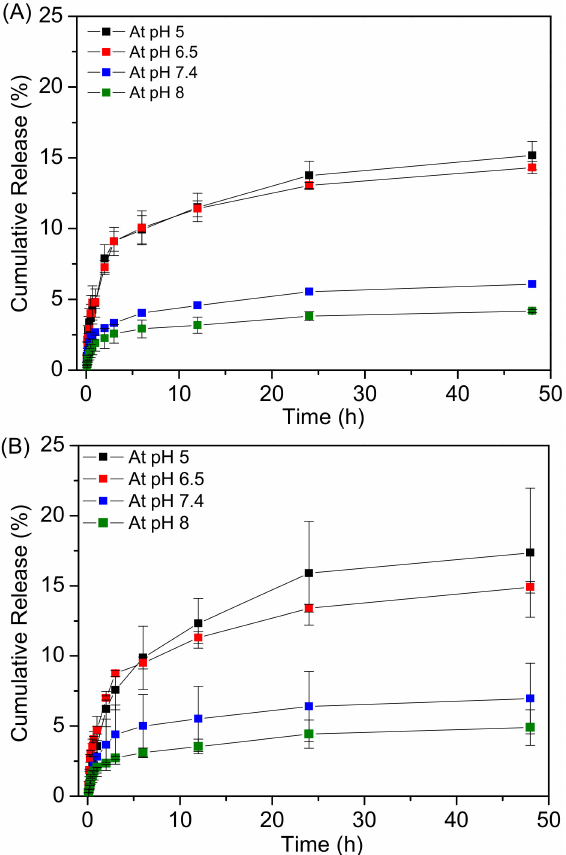
Figure 7. Drug release pattern of DOX loaded in: ( A ) Fe 3 O 4 @MSN-PDEAEMA and ( B ) Fe 3 O 4 @MSN- PDEAEMA-FA in different pH values at 37 ◦